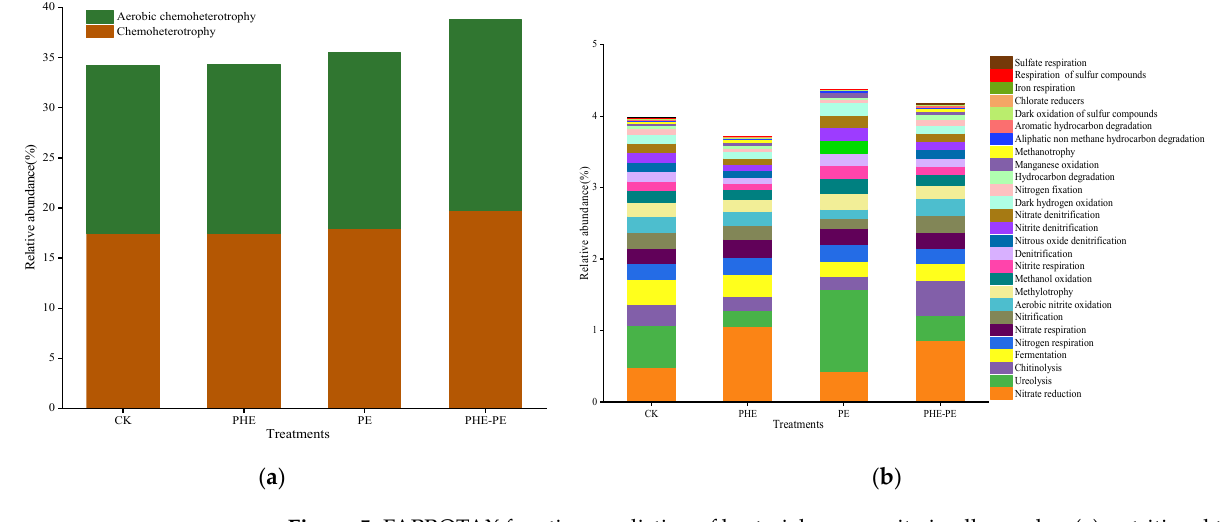
Figure 5. FAPROTAX function prediction of bacterial community in all samples: ( a ) nutritional types; ( b ) elemental cycles and degradation. Table 4. Metabolic pathway abundance based on KEGG database at level